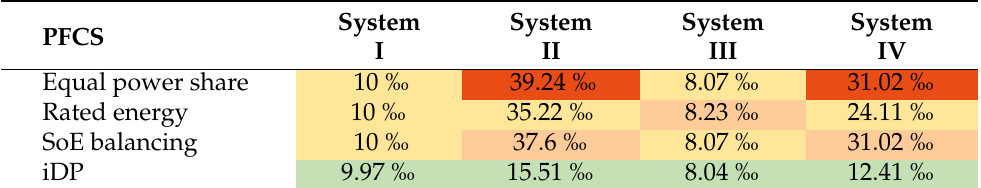
Table 4. Cumulative loss of energy of different power split methods for load profile II. Energy losses are given relative to the total energy of the